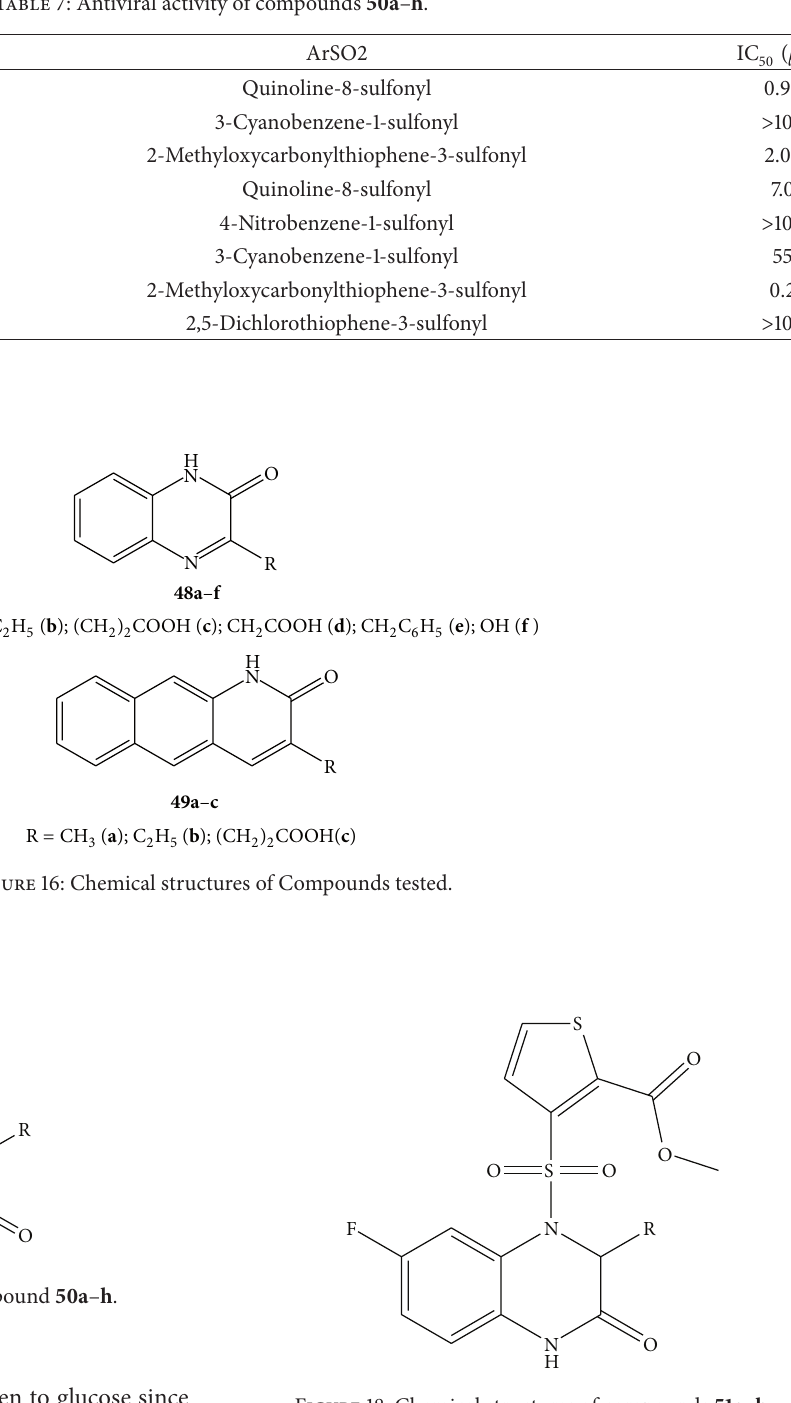
Figure 18: Chemical structures of compounds 51a – h